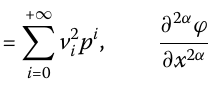
Figure 3 ( a ) Numerical solution of Eq. (72) for α = 1, ( b ) 3D surface solution for α = 1 surface solution behavior for α = ln(2) E 10 ( v ( x , t )) = | v ext . ( x , t ) – v appr . ( x , t ) | , α = 1, ( f ) Absolute error E 20 ( v ( x , t )) = | v ext . ( x , t ) – v appr . ( x , t ) | , α = 1, ( g ) Absolute error of the LFHAM E 10 ( v ( x , t )) = | v ext . ( x , t ) – v appr . ( x , t ) | for α = ln(2)